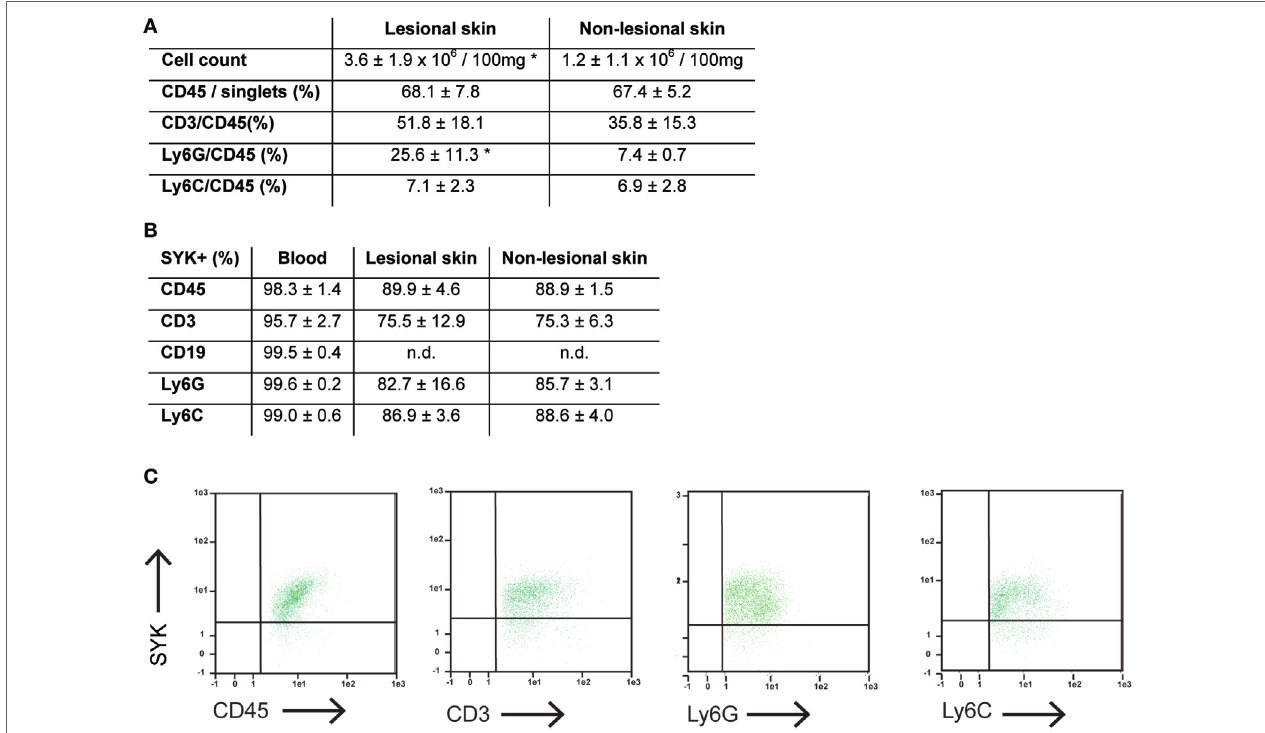
FigUre 3 | Expression of CD45 + cells is increased, while proportional expression of SYK in leukocytes remains constant in lesional versus non-lesional skin in mice with experimental epidermolysis bullosa acquisita (EBA). (a) Specimen from lesional and non-lesional skin of mice injected with anti-type VII collagen IgG were analyzed for quality and quantity of dermal leukocyte infiltration. Yield of cells was higher from lesional skin compared to non-lesional skin from corresponding sites. Regarding the relative distribution of all leukocytes (CD45 + ) or subsets, we observed a difference regarding neutrophils (CD45 + /Ly6G + ; * p < 0.05, t -test). Hence, the relative distribution of the dermal infiltrate remains constant, while the absolute number of CD45 + cell increases in the skin of mice with experimental EBA. CD19 + cells were not observed in the skin samples (not shown). (B) Separately, expression of SYK was evaluated in CD45 + cells obtained from lesional and non-lesional skin. Relative expression of SYK in CD45 + , CD45 + /CD3 + , CD45 + /Ly6G + , and CD45 + /Ly6C + was identical in both groups. CD45 + cells from blood were used as positive control. (c) Representative FACS stainings from lesional skin, gated on CD45 + /singlet cells. All data are based on four to five samples per